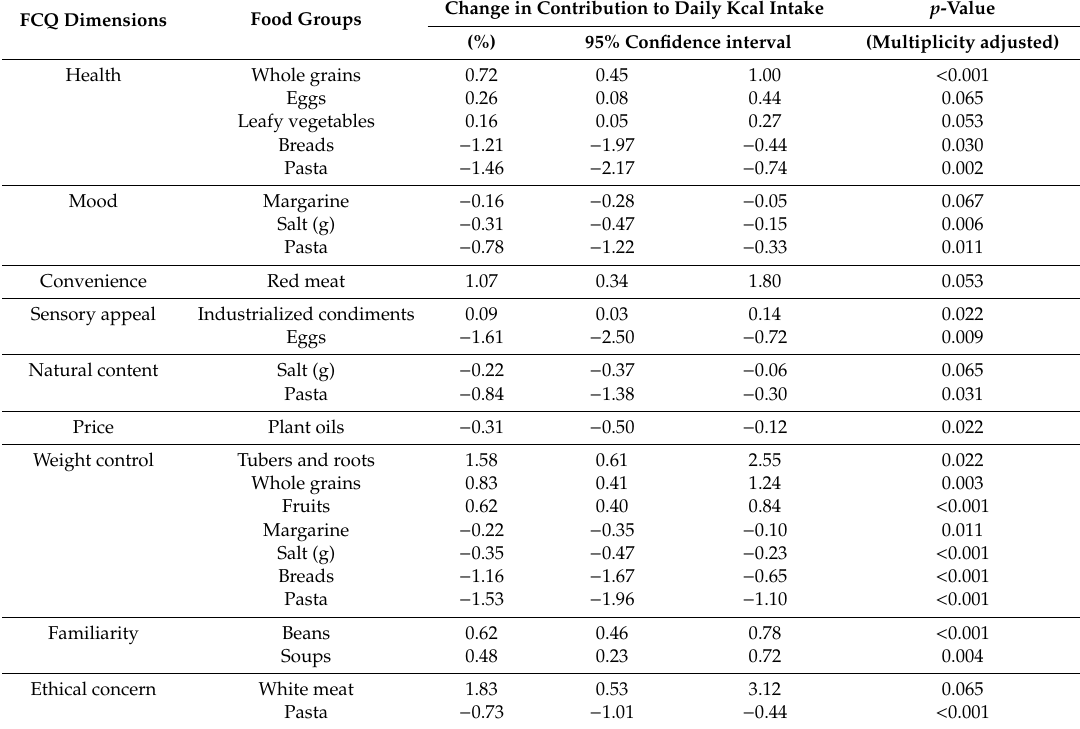
Table 5. Change in the relative contribution of each food group to total daily energy consumption according to the di ff erent motivations for food choice in manufacturing workers of the State of Rio Grande do Norte, Brazil,